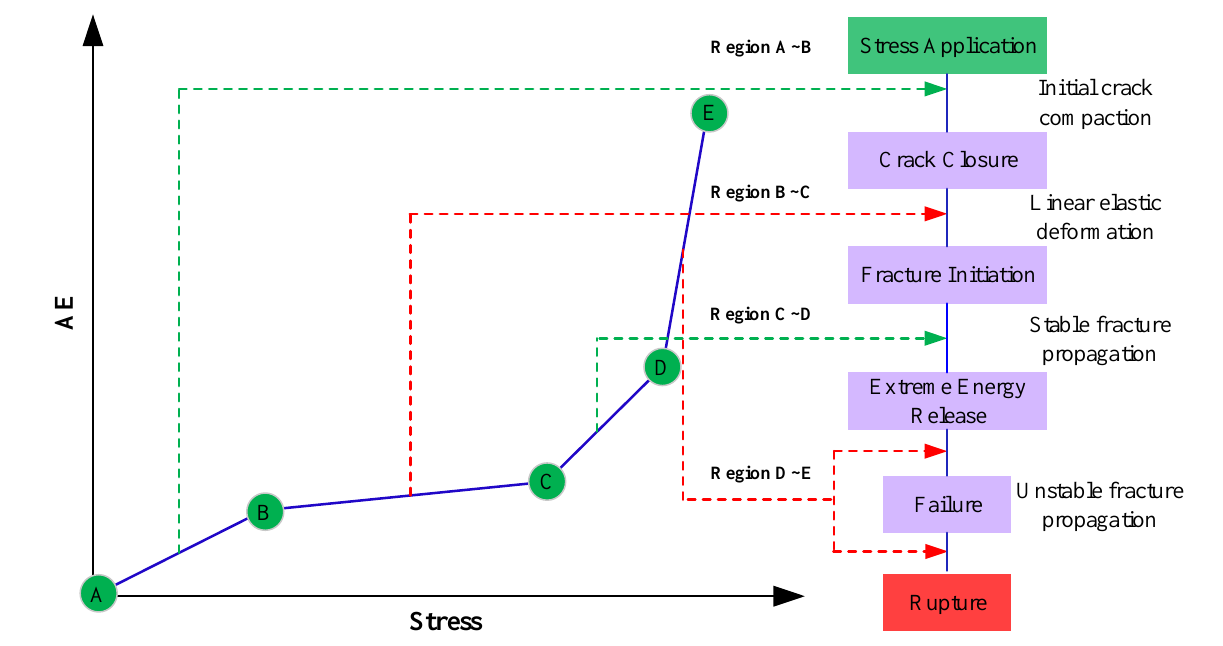
Figure 14. The relationship between the AE signal and stress with rock deformation (after [39]).